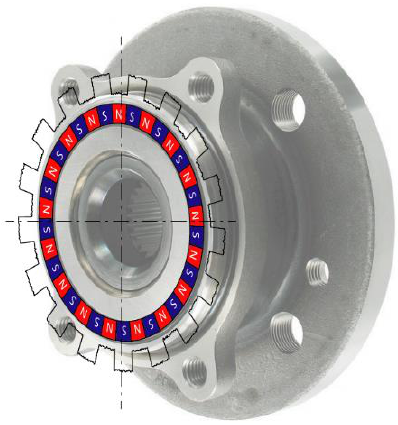
Figure 12. Incremental magnetic encoder, also known as ABS encoder (SKF VKBA 6634).